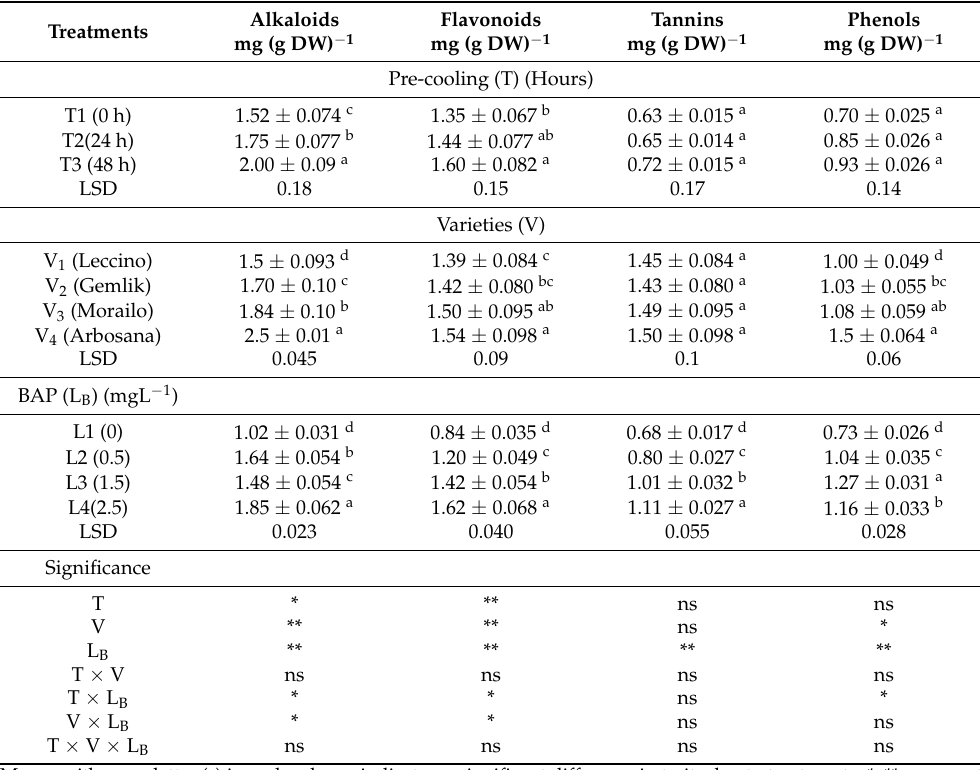
Table 4. Effect of different pre-cooling treatments and varying concentrations of BAP on secondary metabolites of different olive genotypes cultured within micropropagation system using OM.